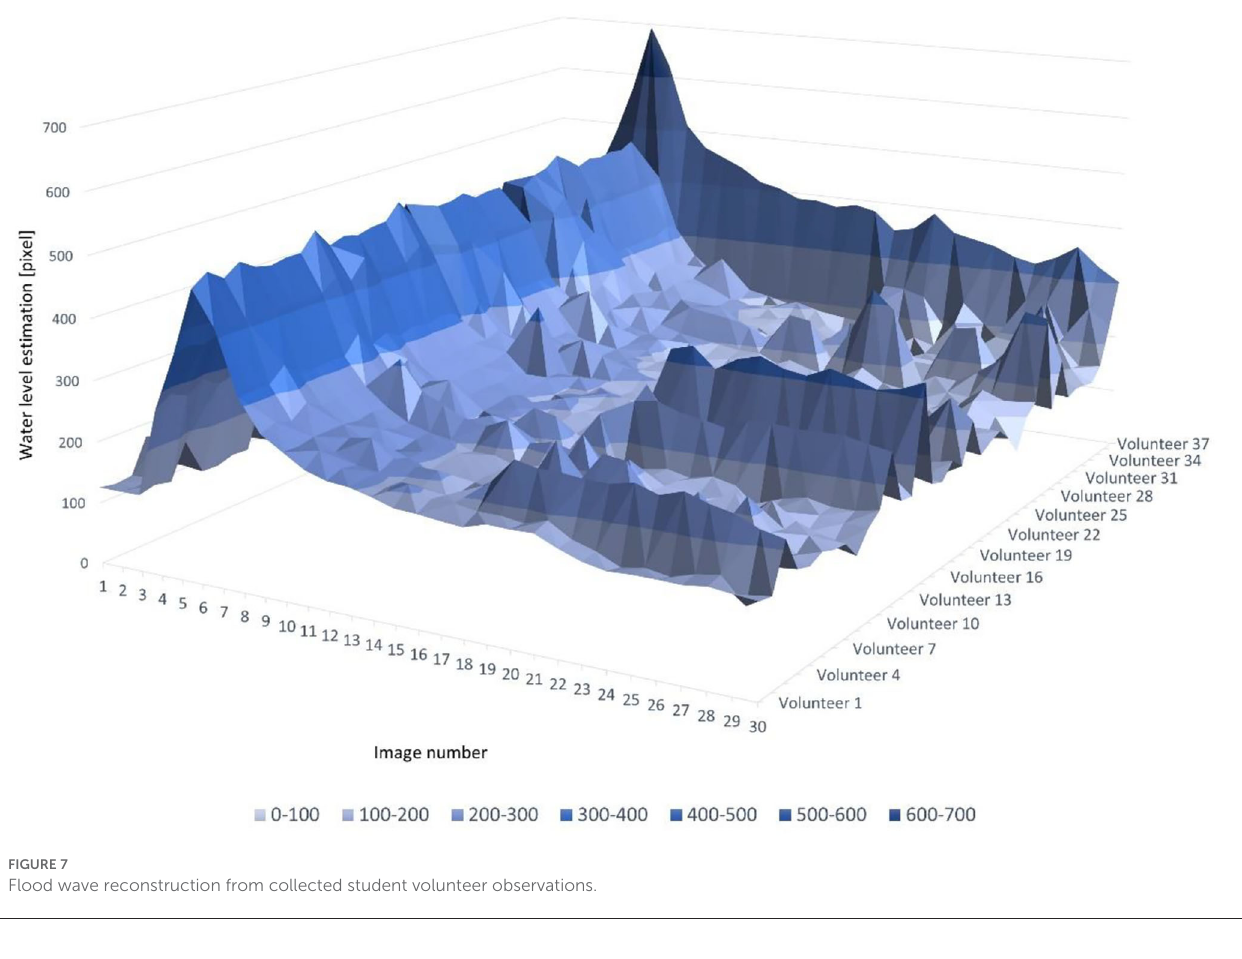
FIGURE7 Flood wave reconstruction from collected student volunteer observations.